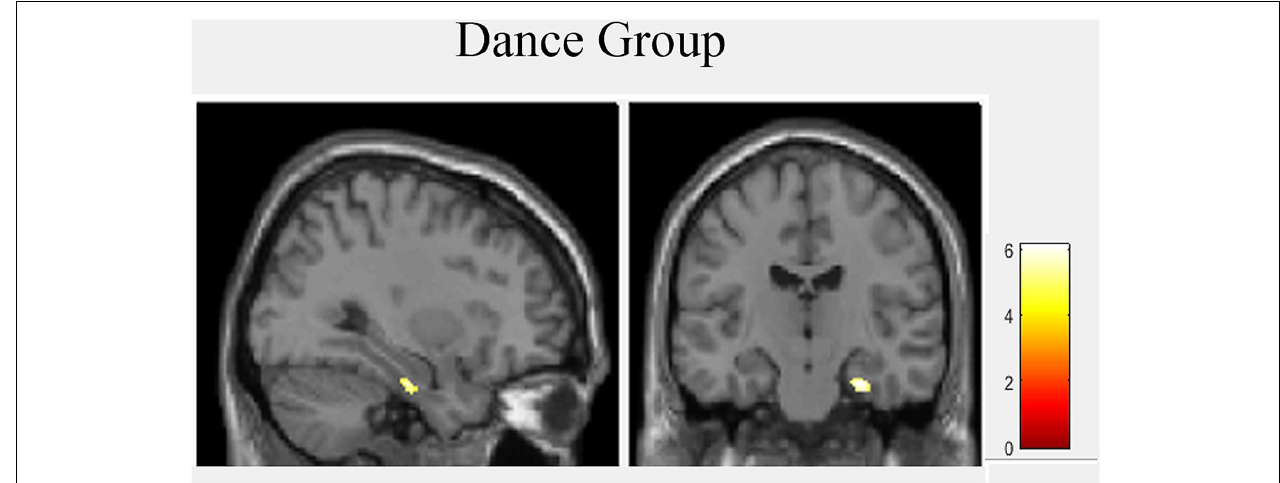
FIGURE 3 | Hippocampal volume increases after 18 month of intervention in dance group.